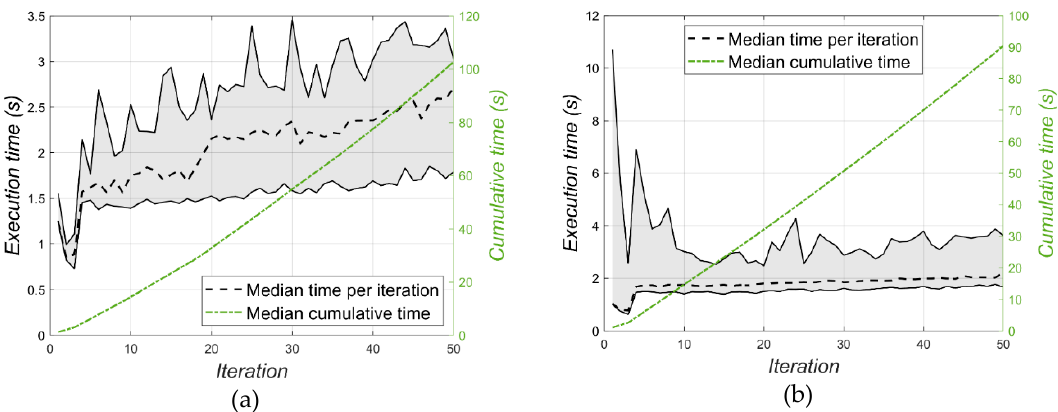
Figure 6. Execution time for the ( a ) Polish dataset errors using LCB-BO and ( b ) Brazilian dataset errors using EI-BO optimized ESN. The black trend line and shaded area are related to the left axis, while the green line represents the cumulative execution time along iterations referred to the right axis scale.